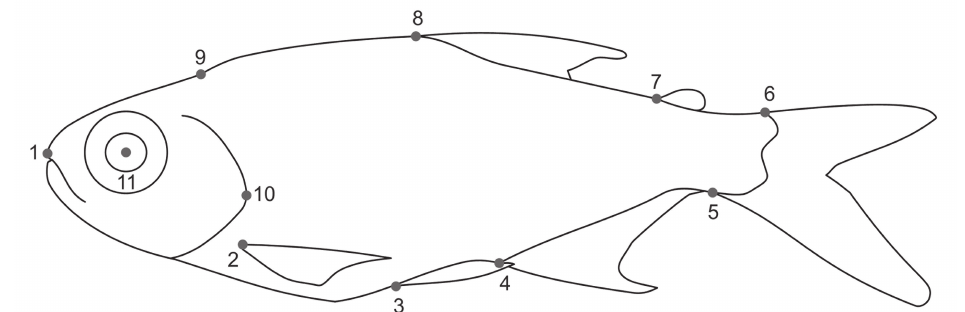
Fig. 2. Sketch of a Hemigrammus coeruleus individual indicating the 11 landmarks used in the morphological analyses. Landmarks were defined as follow: 1 - snout tip; 2 - dorsal insertion of pectoral fin; 3 - anterior insertion of pelvic fin; 4 - anterior insertion of anal fin; 5 - ventral insertion of caudal fin; 6 - dorsal insertion of caudal fin; 7 - anterior insertion of adipose fin; 8 - anterior insertion of dorsal fin; 9 - supra-occipital; 10 - endpoint of the opercle; 11 - central point of